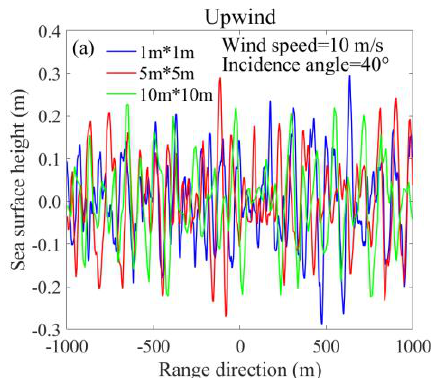
Figure 25. Comparison of the distributions of sea surface with different facet sizes in the upwind ( left ) and crosswind ( right ) directions at the incidence angle of 40° and wind speed of 10 m/s. The surface size is 2 km × 2 km. ( a , b ) Pdfs for elevation; ( c , d ) pdfs for slope; ( e , f ) pdfs for backscatter under VV polarization. Dashed curves, facet size is 1 m × 1 m; solid curves, facet size is 5 m × 5 m; solid curves with dot, facet size is 10 m × 10 m.